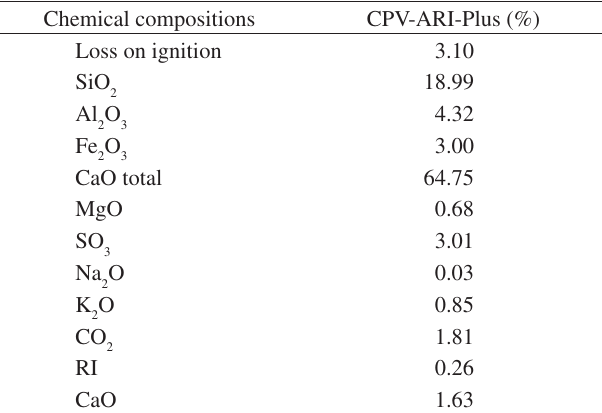
Table 1. The chemical compositions of cement obtained from the producer. Chemical compositions